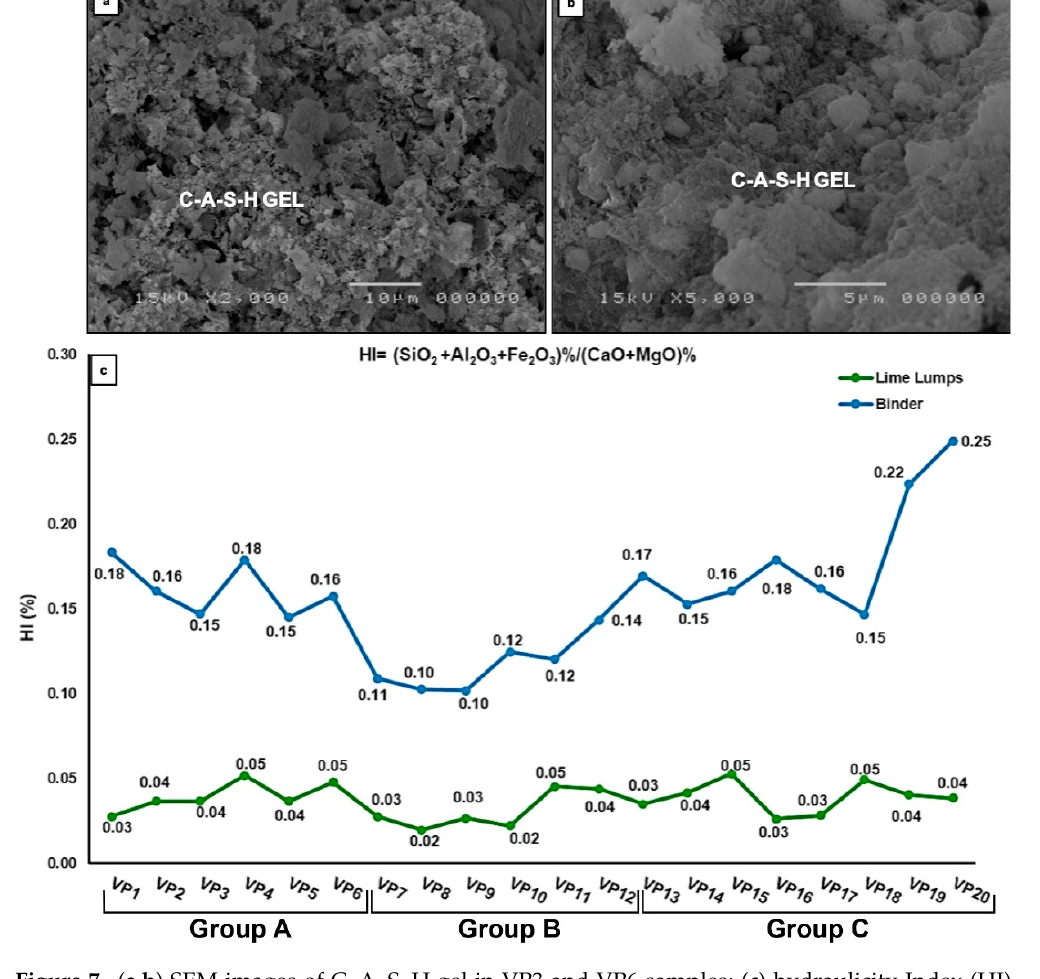
Figure 7. ( a,b ) SEM images of C-A-S-H gel in VP3 and VP6 samples; ( c ) hydraulicity Index (HI), lime lumps (green line) and binder (blue line) for analyzed mortars.